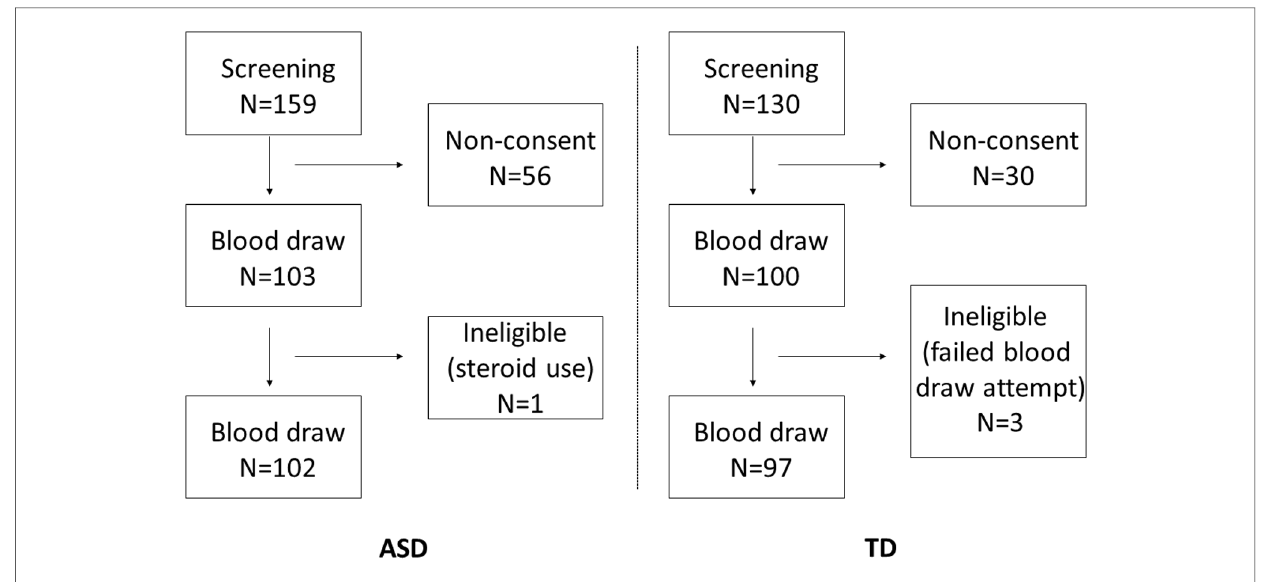
FIGURE 1 Flowchart of disposition of subjects in each study arm.